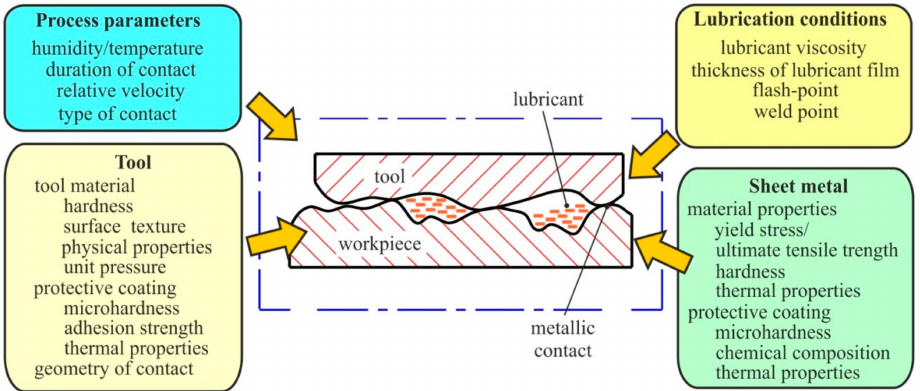
Figure 1. Scheme of a tribological system in sheet metal